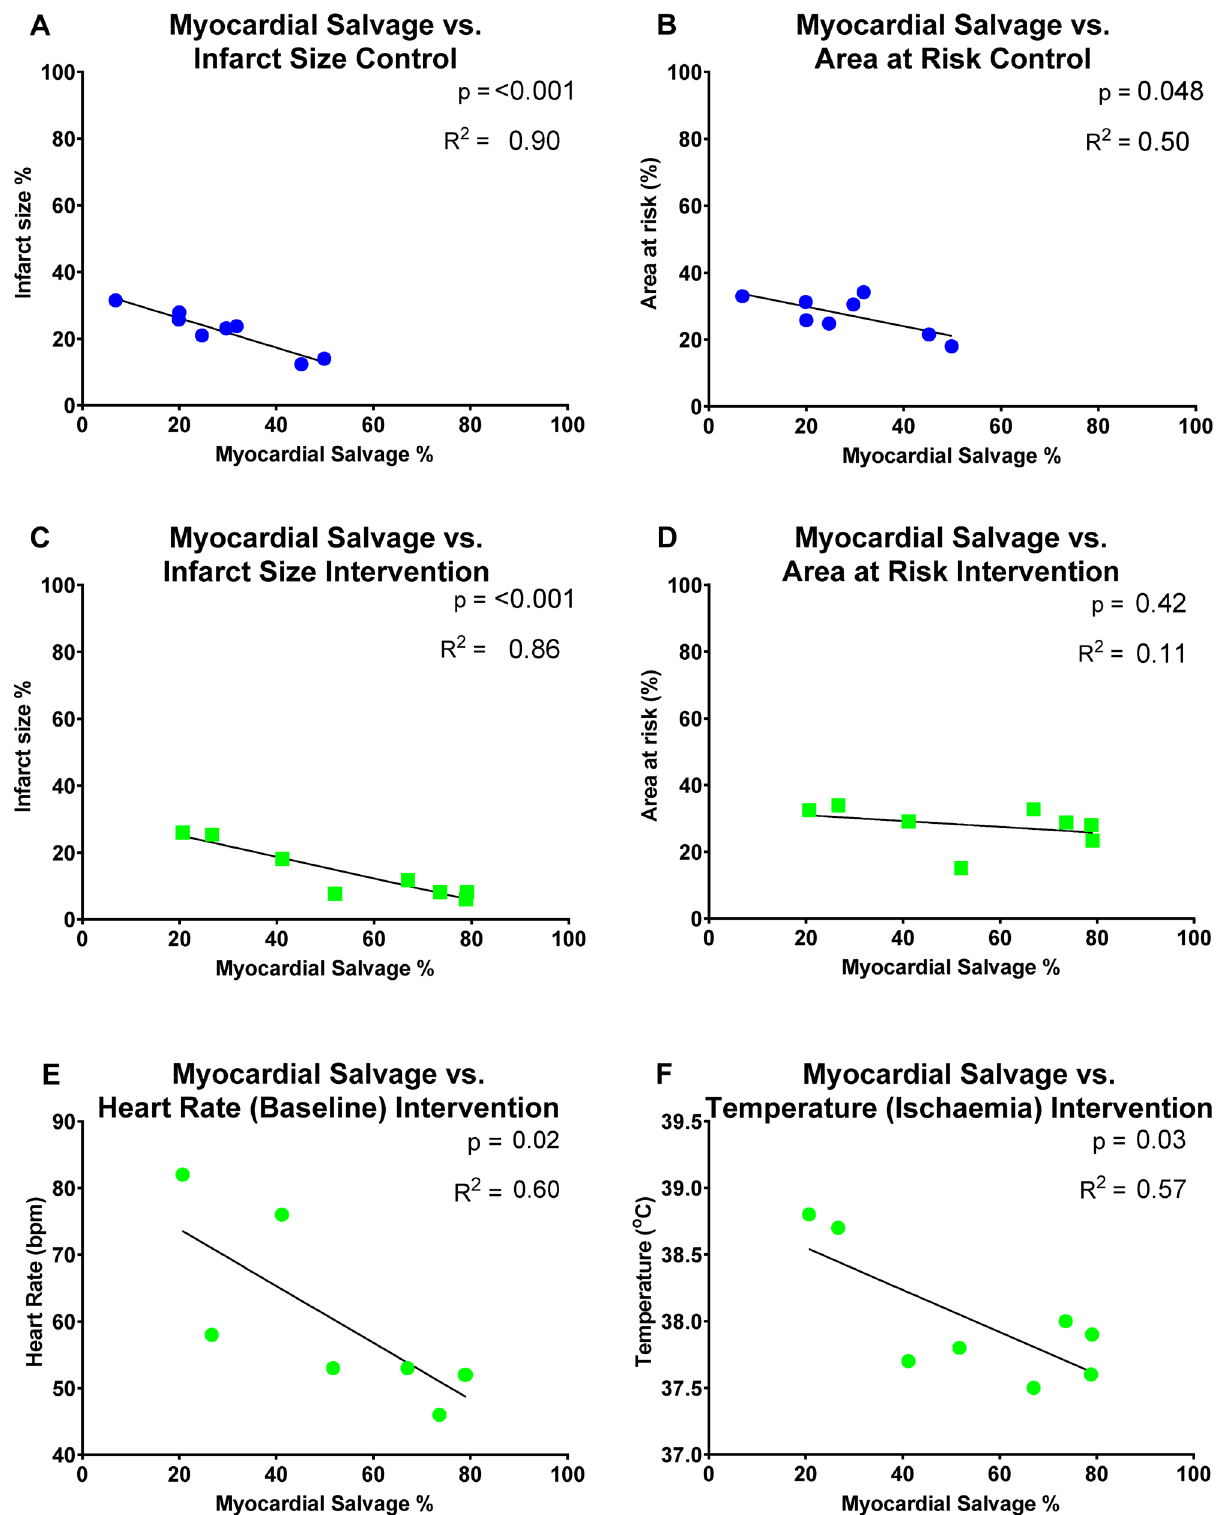
Figure 4. Myocardial salvage correlations with infarct size, area at risk, heart rate and body temperature. See “Results” section for